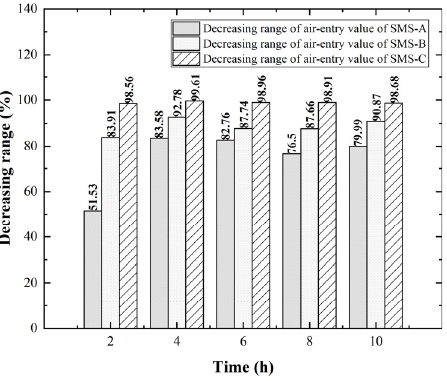
Figure 10. Logarithmic variations of air-entry values of soil after different hydrophobic treatments (the air-entry value at 0 is the air-entry value of plain soil).